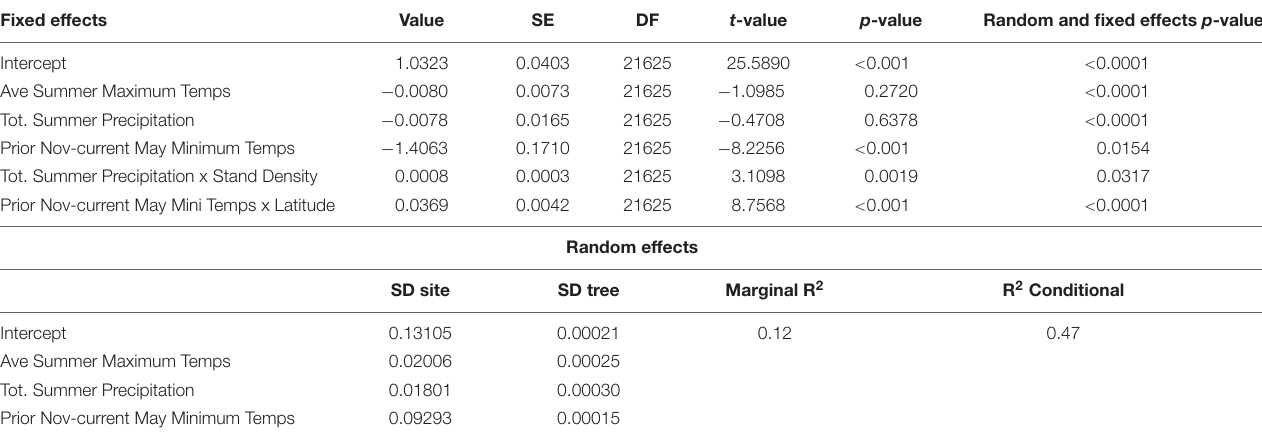
TABLE 2 | Summary of the selected linear-mixed effects model of tree-ring width